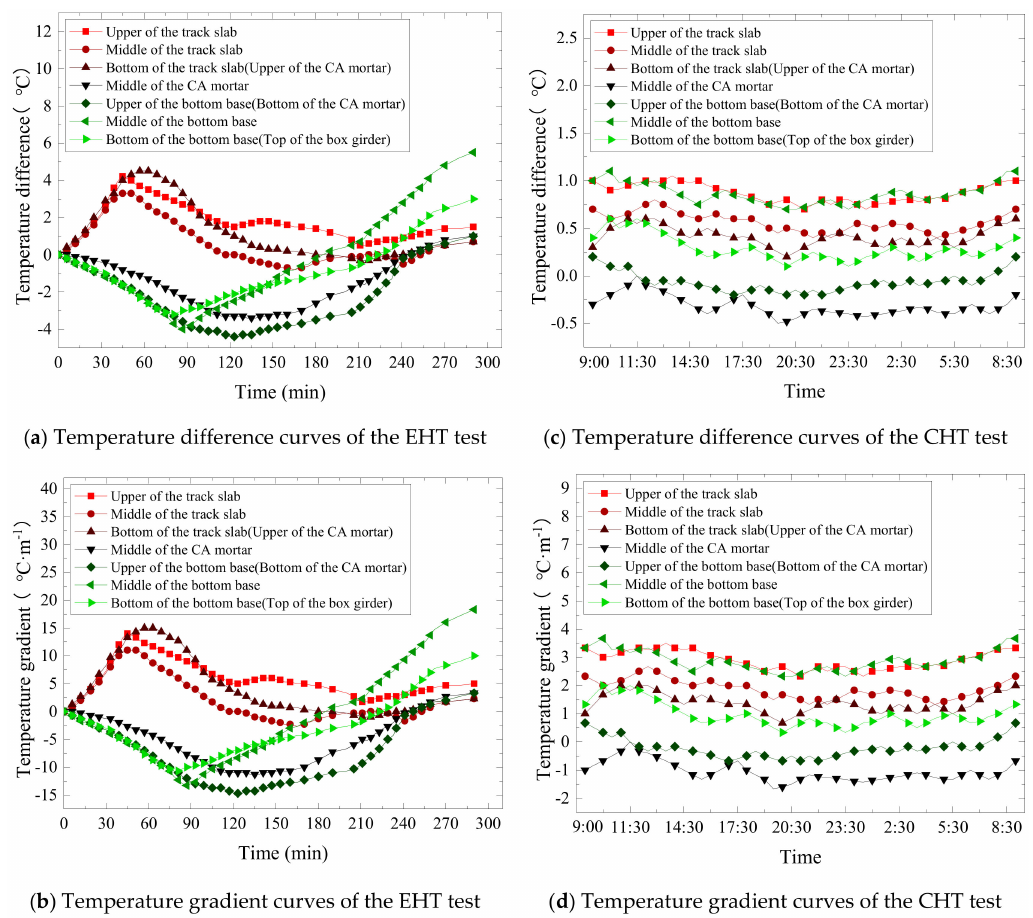
Figure 10. Transverse temperature di ff erence and temperature gradient curves of the